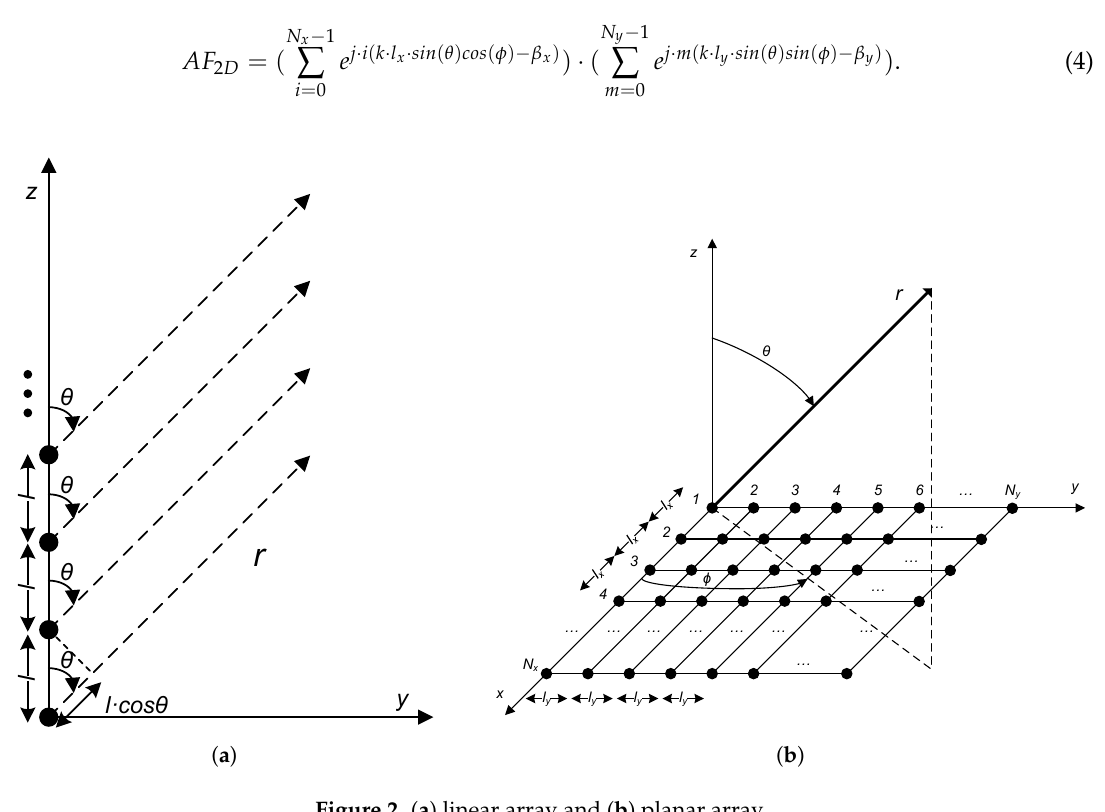
Figure 2. ( a ) linear array and ( b ) planar